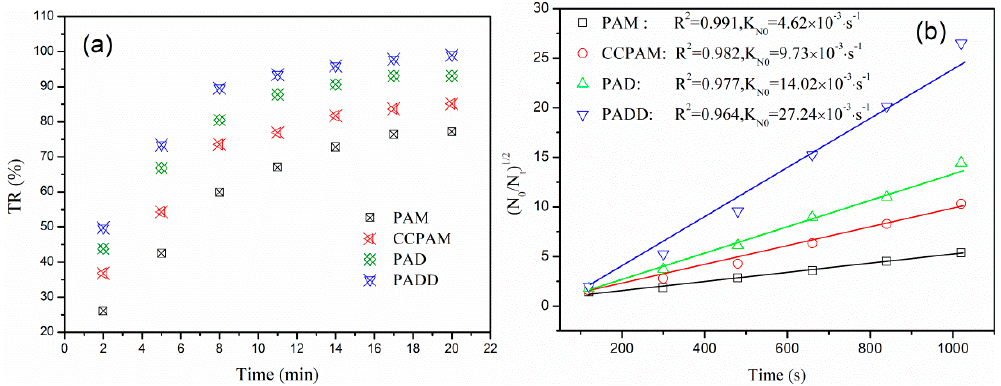
Figure 8. The effects of flocculation time on ( a ) turbidity removal rate of coal mine wastewater and ( b ) (N 0 /N t ) 1/2 .